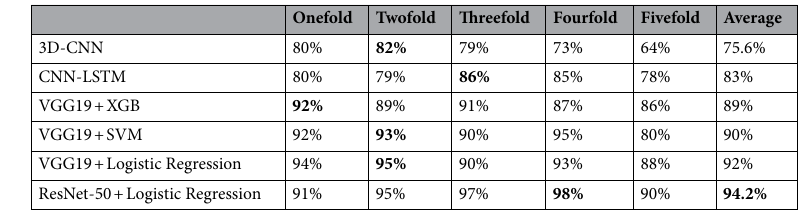
Table 2. Accuracy of cross-validation in baseline models and the proposed model. Significant values are in bold. 3D-CNN three-dimensional convolutional neural network, CNN-LSTM convolutional neural network– long short-term memory model, VGG19 VGG architecture with 19 layers and our custom fully connected layers, ResNet-50 ResNet architecture with 50 layers, XGB XGBoost Classifier, SVM support vector machine.